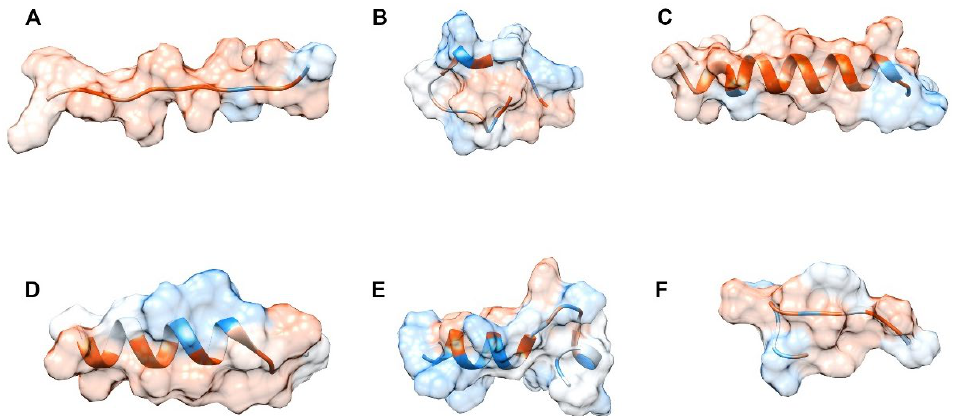
Figure 3. De novo prediction of tertiary structures. Model peptide visualization as predicted by UCSF Chimera ® , employing color variations based on the residues hydrophobicity score of the Kyte- Doolittle scale [60], where blue is for the most hydrophilic residues and white and orange for the most hydrophobic ones. ( A – C ) correspond to the AHB-1, AHB-2, and AHB-3 peptides. ( D – F ) correspond to Frenatin 2.3S, Buforin II, and TP2.